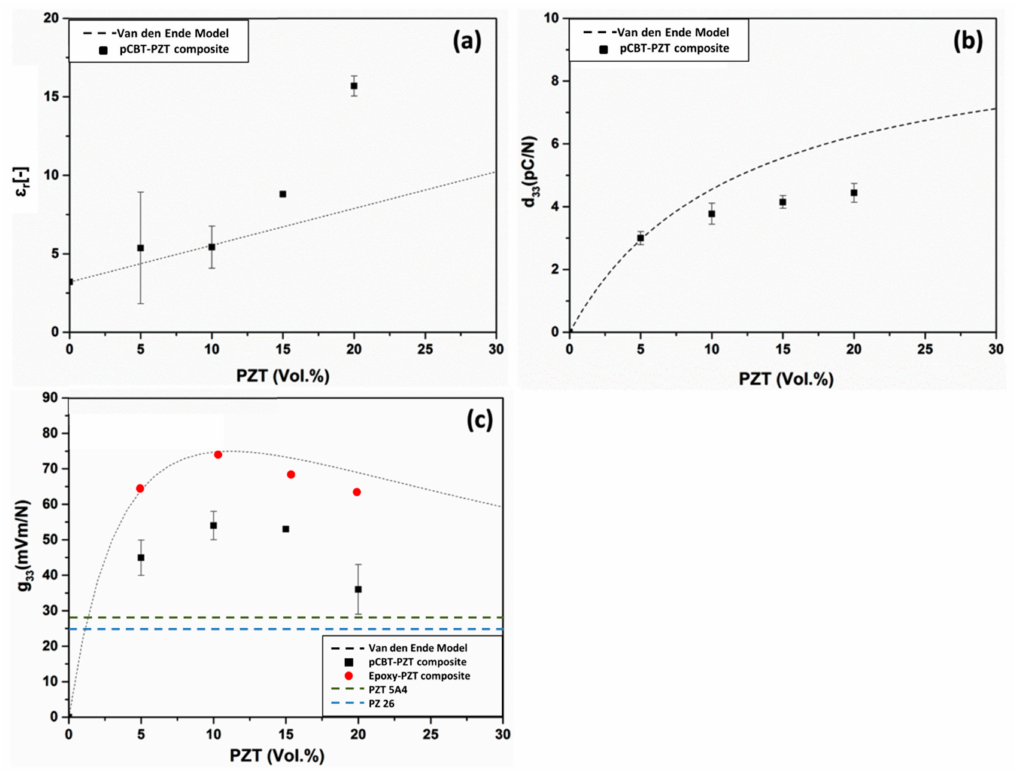
Figure 4. Piezoelectric and dielectric properties of PZT–pCBT composites; ( a ) variation of dielectric constant with increasing vol% of PZT; ( b ) variation of d 33 with increasing vol% of PZT; ( c ) variation of g 33 with increasing vol% of PZT compared with epoxy–PZT composite [3].